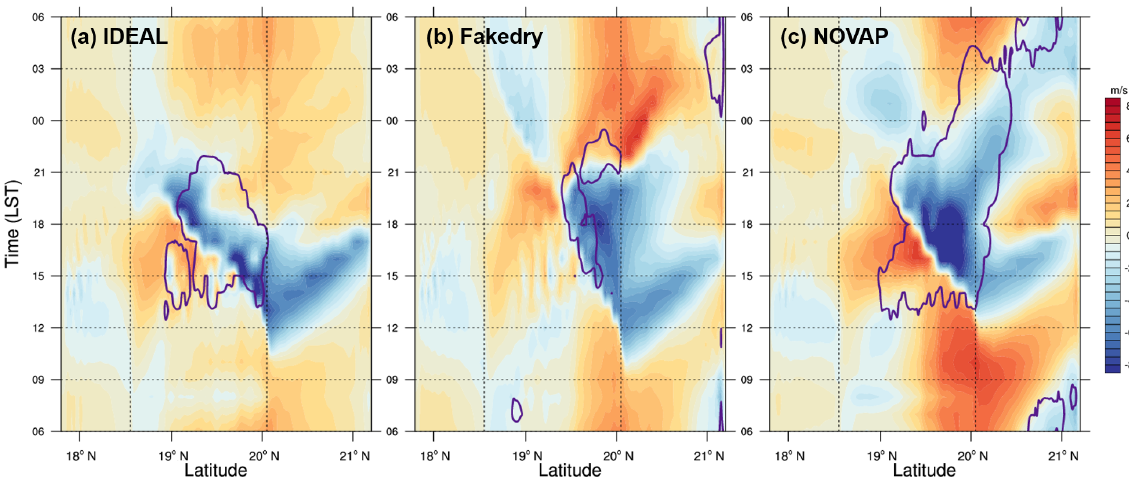
Figure 16. Hovmöller diagrams of perturbation meridional wind component on the second-lowest model level for horizontal wind (shading) in the (a) IDEAL, (b) Fakedry, and (c) NOVAP experiments, respectively. Precipitation exceeding 0.1mmh − 1 is enclosed by the heavy purple contours. The two vertical dashed lines indicate the edges of the